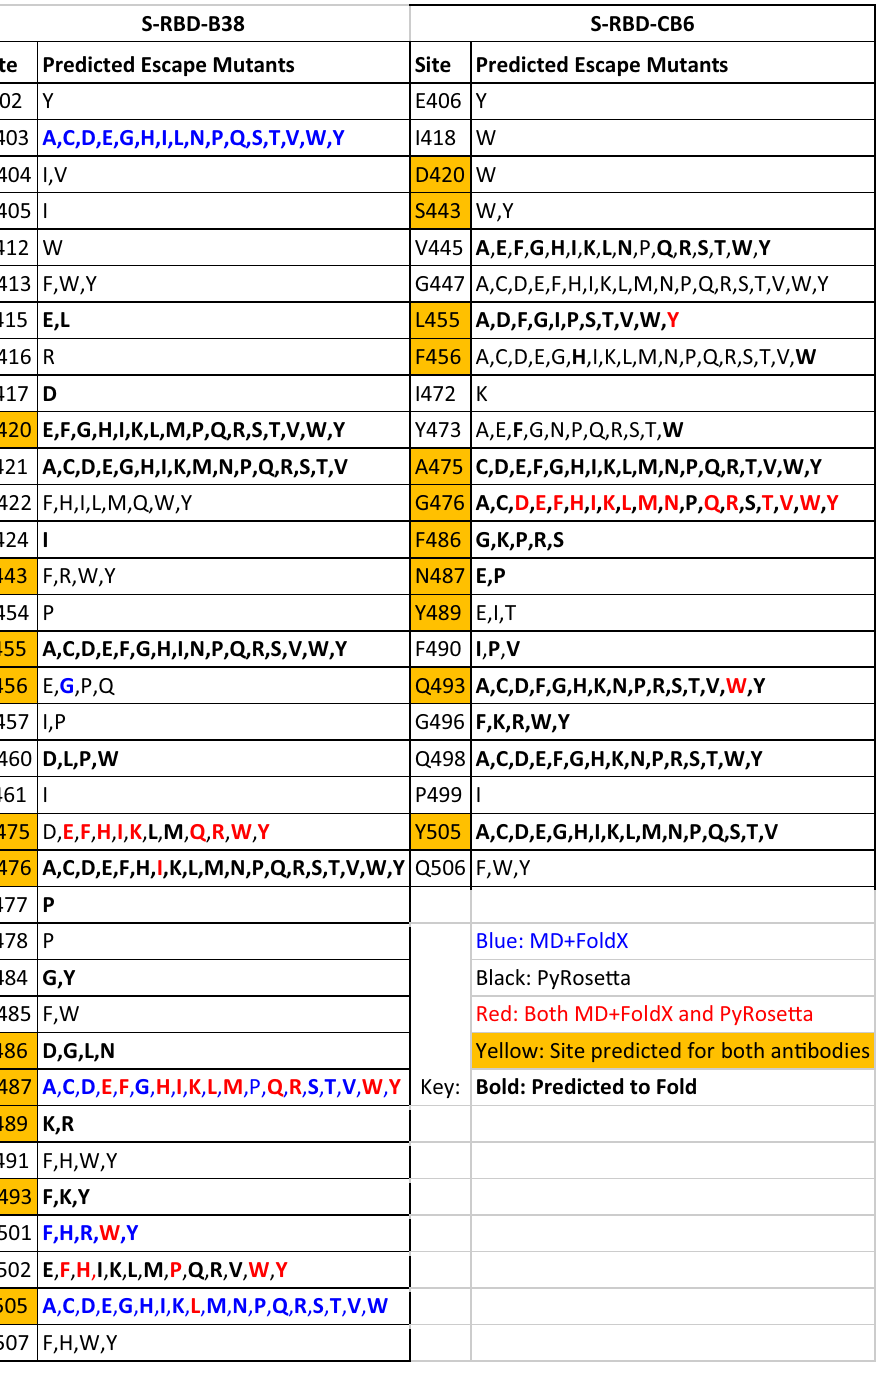
Table 1. Union dataset of predicted escape mutations for B38 and CB6 antibodies based on both MD + FoldX and PyRosetta simulations The left and right tables show results for B38 and CB6, respectively. For each subtable, the left column is the S-RBD site and the right contains the mutations predicted by either MD + FoldX and/or PyRosetta to lead to antibody escape. Predicted escape mutations are colored based on whether both methods predict escape (red) , only MD + FoldX predicts escape (blue), or only PyRosetta predicts escape (black). The yellow highlighted sites are those predicted to contain antibody escape mutations for both antibodies. Bold font denotes mutations that are predicted to allow